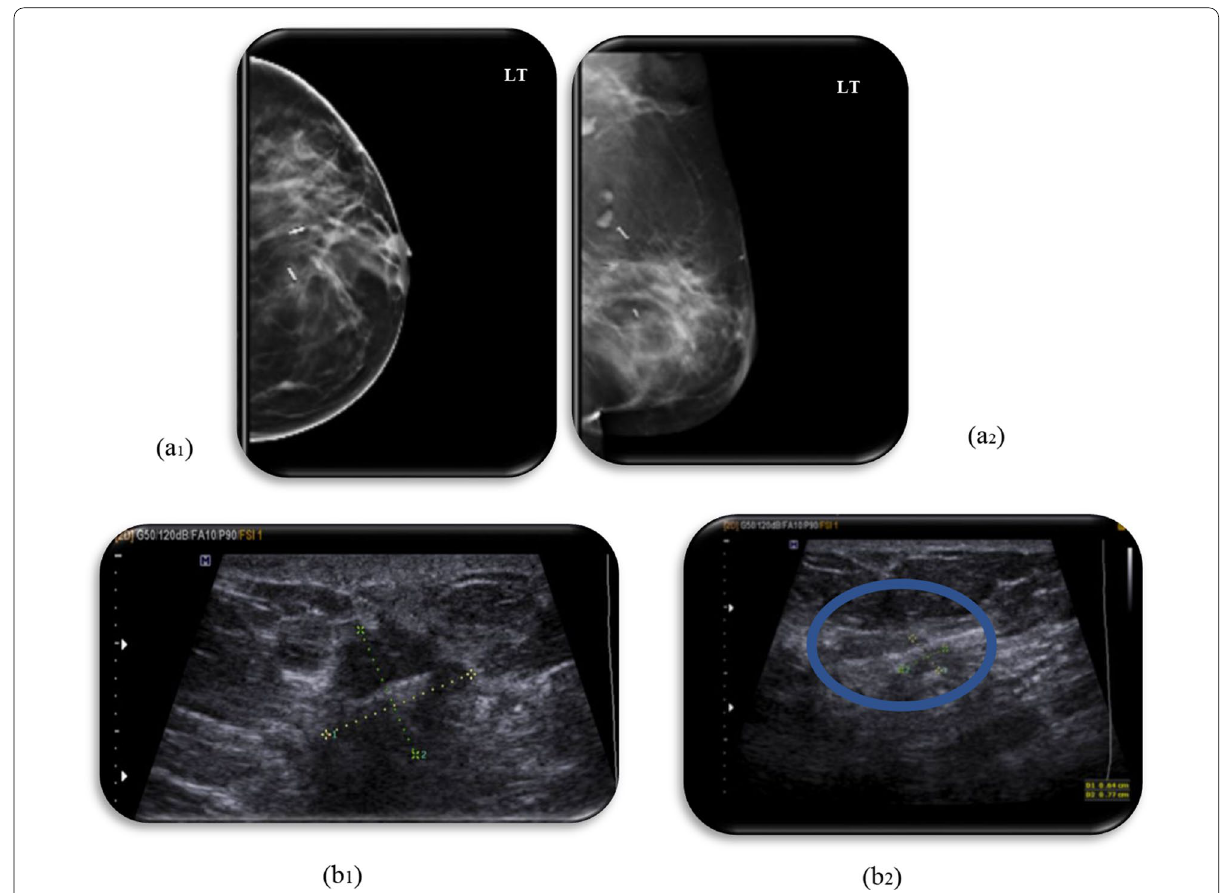
Fig. 7 37-year-old patient with left breast lump, recently pathologically proven invasive ductal carcinoma (IDC) grade II came for clip insertion before the start of chemotherapy, Breast sonomamography after clip placement a1 CC view, a2 MLO view and b1 ultrasound images showing the surgical clip seen within the left breast lobulated hypoechoic mass ( b2 ) with an adjacent smaller satellite lesion with a clip seen inside, yet both clips show no artifact interfering with images interpretation. MRI of both breasts c1 T1WIs first clip inside lesion c2 T1WIs second clip and c3 post contrast) done showing a signal void of two metallic surgical clips seen at UOQ, still seen inside two left sided ill-defined speculated malignant mass lesions showing evidence of post contrast enhancement. After completing the course of neoadjuvant therapy, follow up sonomamography was done d1 and d2 shows two surgical clips still noted in left breast solid masses showing regressive course as regards the size with the clips still seen in the same site compared to the previous